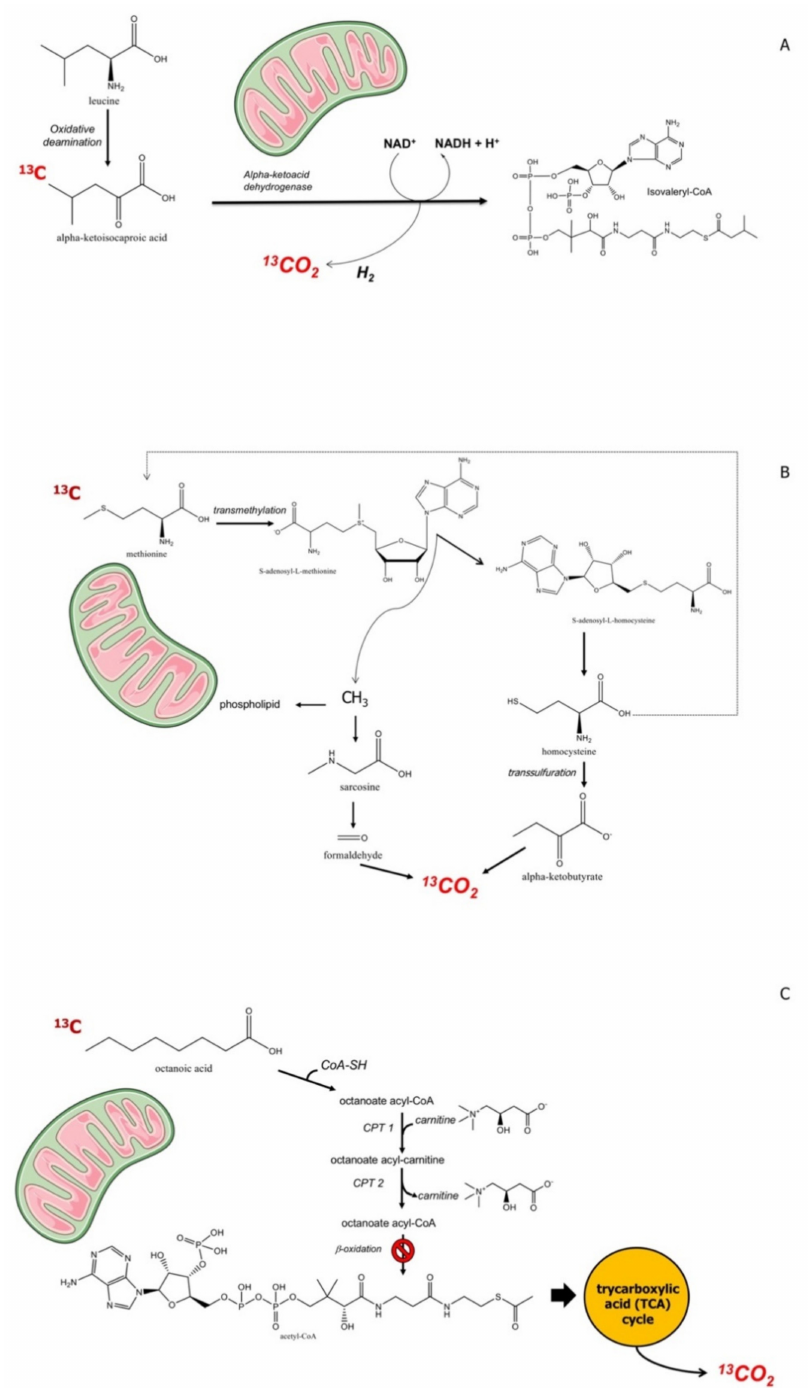
Figure 5. The figure shows the mitochondrial metabolism of alpha-ketoisocaproic acid ( A ), me- thionine ( B ), and octanoic acid ( C ). The 13 C-enriched substrates become donors of 13 CO 2 which is promptly transported to the lung and excreted in